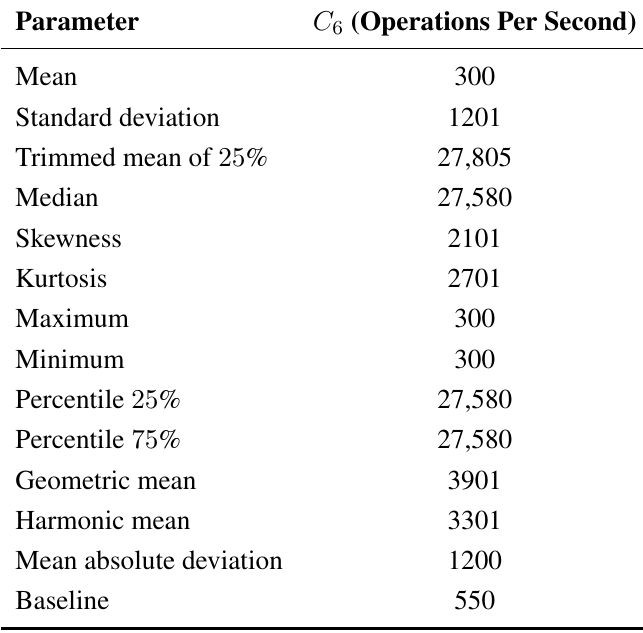
Table 1. List of parameters and the number of operations per second